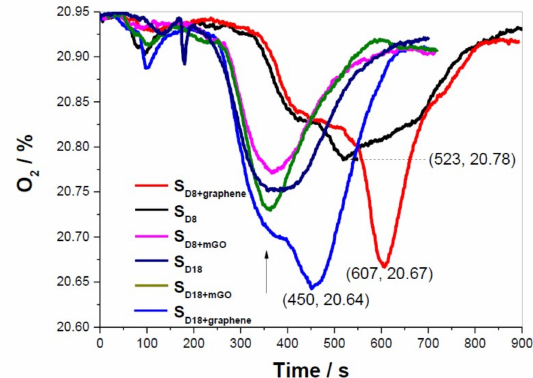
Figure 4. O 2 concentration of exhaust pipe during combustion of samples.